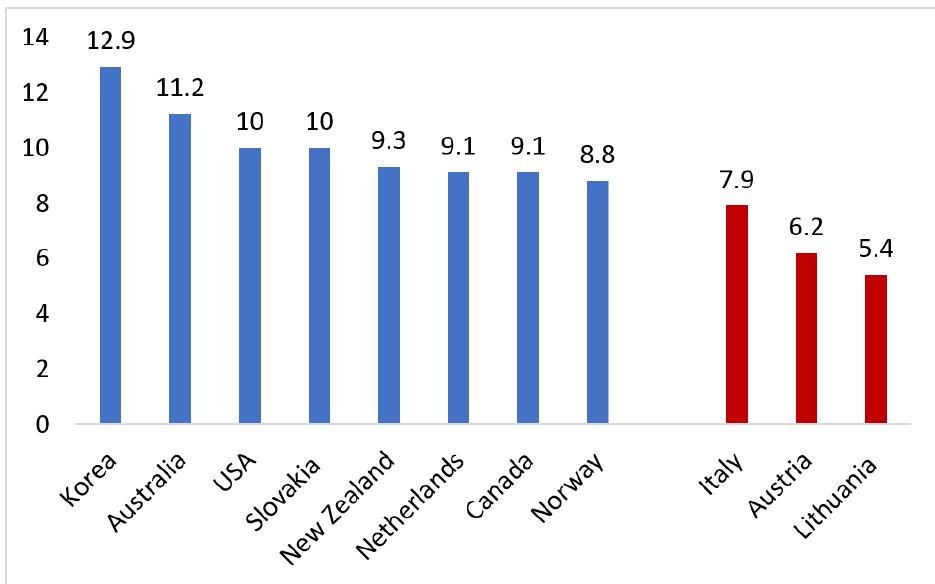
Figure 1. Age-standardized incidence rate during 2008–2021 for colorectal cancer among adults ages 20–49 years worldwide. Shading indicates trend in incidence rates based on 10-year average annual % change; blue, significant increase; red, significant decrease. The figure was recreated by using the incidence rates from Siegel et al. 2019 [5].